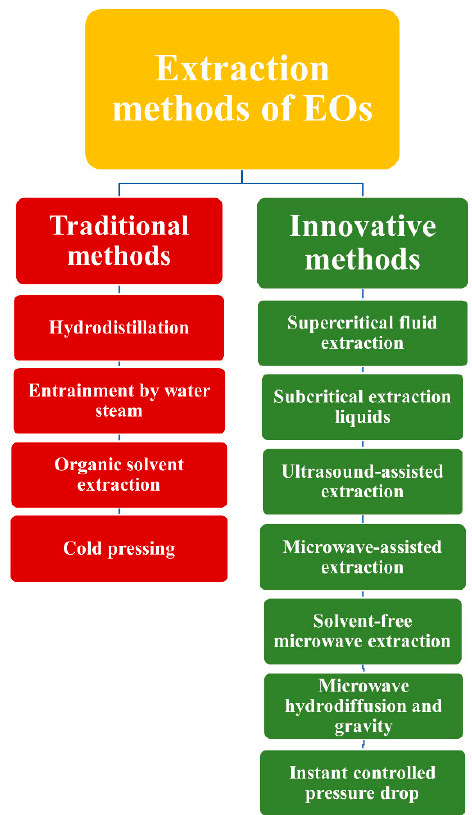
Figure 1. Possible extraction methods for EOs classified into traditional and innovative approaches [2].